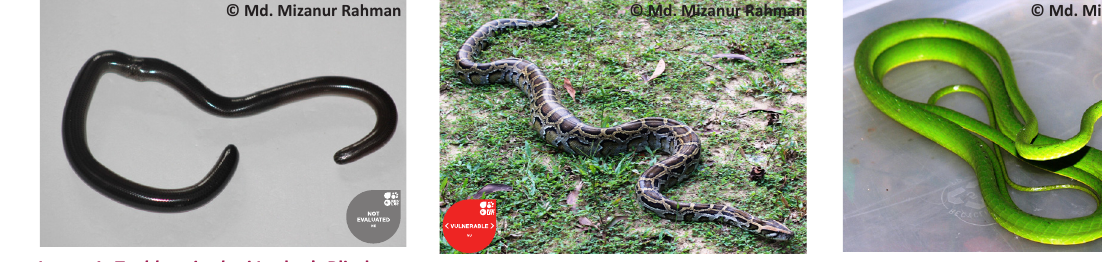
Image 2. P ython bivittatus Burmese Python Image 3. Ahaetulla prasina Short-nosed